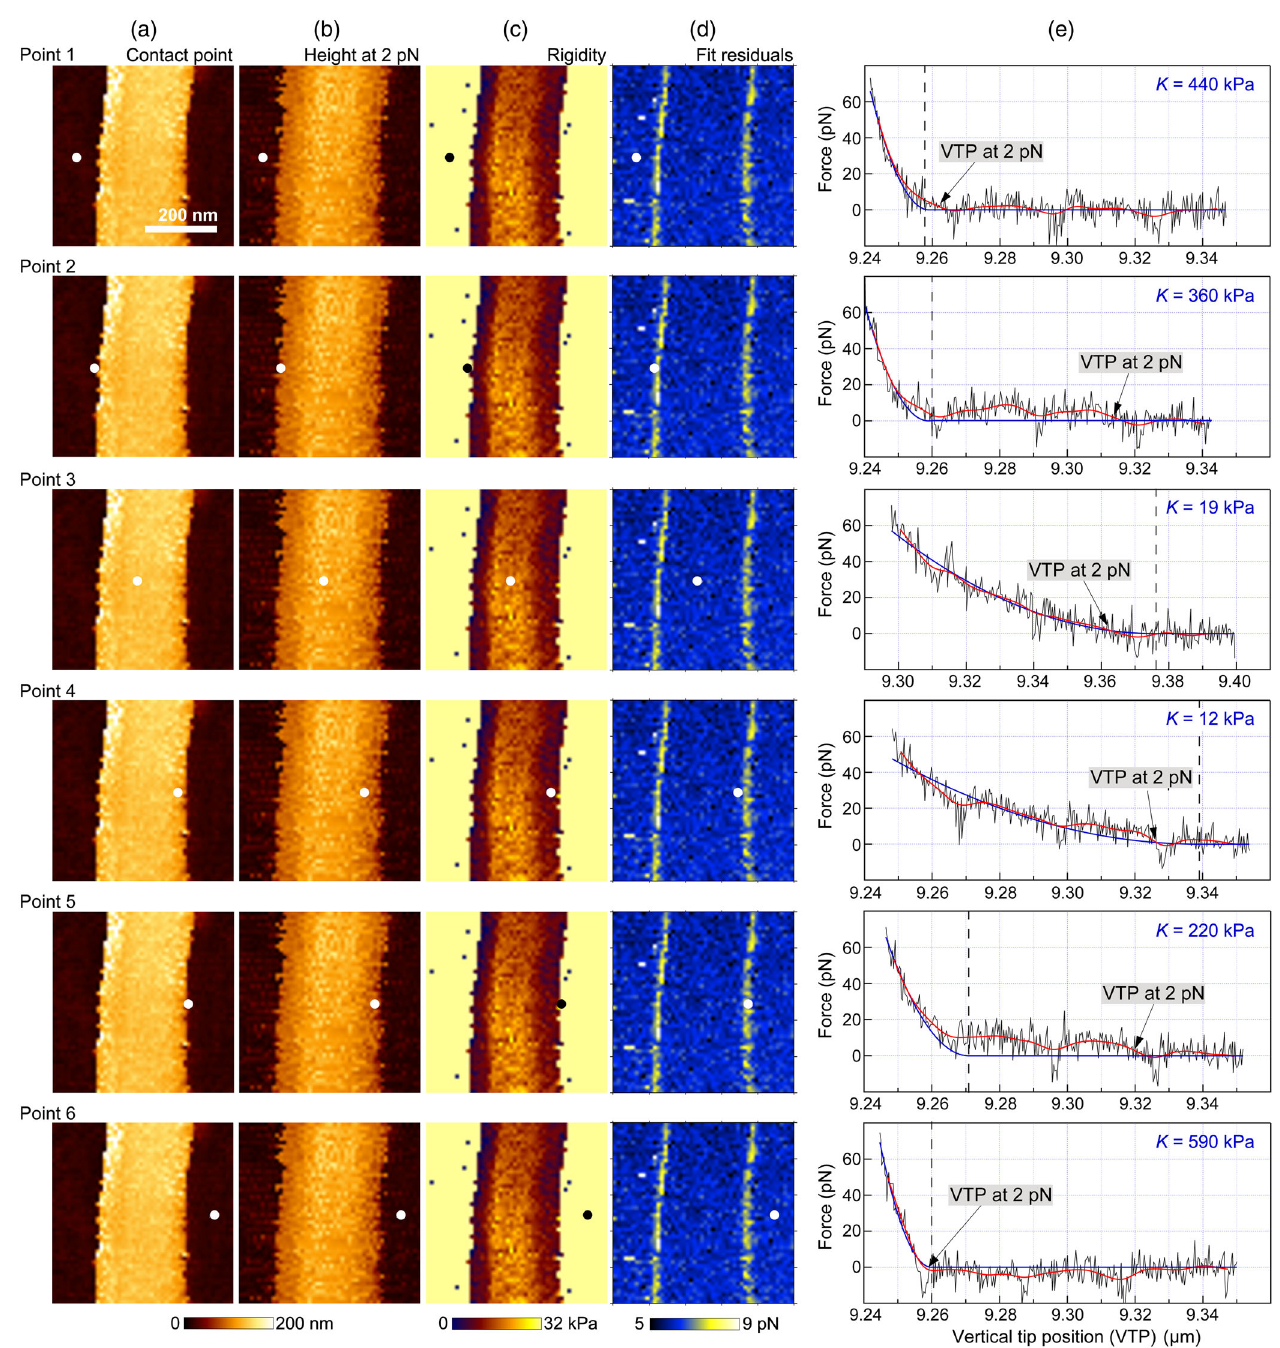
FIG. 11. Determination of the height and width of a membrane nanotube. (a) Contact point (i.e., height at zero force) maps. (b) Maps of the height at 2 pN. (c) Rigidity maps. (d) Maps of fit residuals. (e) Force-distance curves collected at locations marked by dots in the maps of (a) – (d). The red lines are the results of smoothing the force curves and are used to build the 2 pN height maps, which provide the best description of the nanotube width. The blue lines come from least-squares fitting of the data using f ¼ K δ 2 for δ > 0 , where f is the force, K the rigidity, and δ the indentation depth. Vertical dashed lines show the position where δ ¼ 0 that we use to determine the local nanotube height. Note that, at points 2 and 5 (edges of the nanotube), the force starts increasing but quickly drops, which indicates that the nanotube has been pushed laterally by the AFM tip. As a result, the contact point and 2 pN height maps show clear